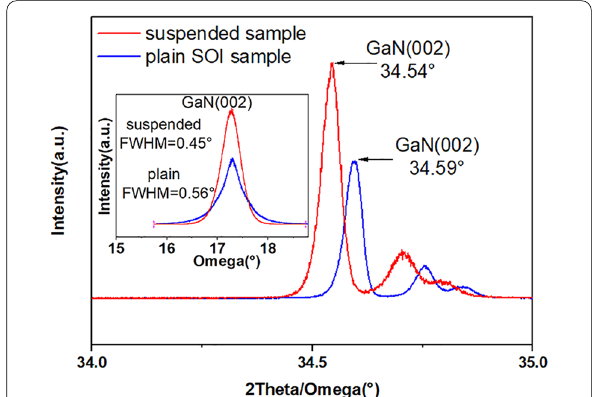
Fig. 4 XRD 2theta/omega scan and rocking curves of epitaxial films on suspended sample (red line) and on plain SOI sample (blue